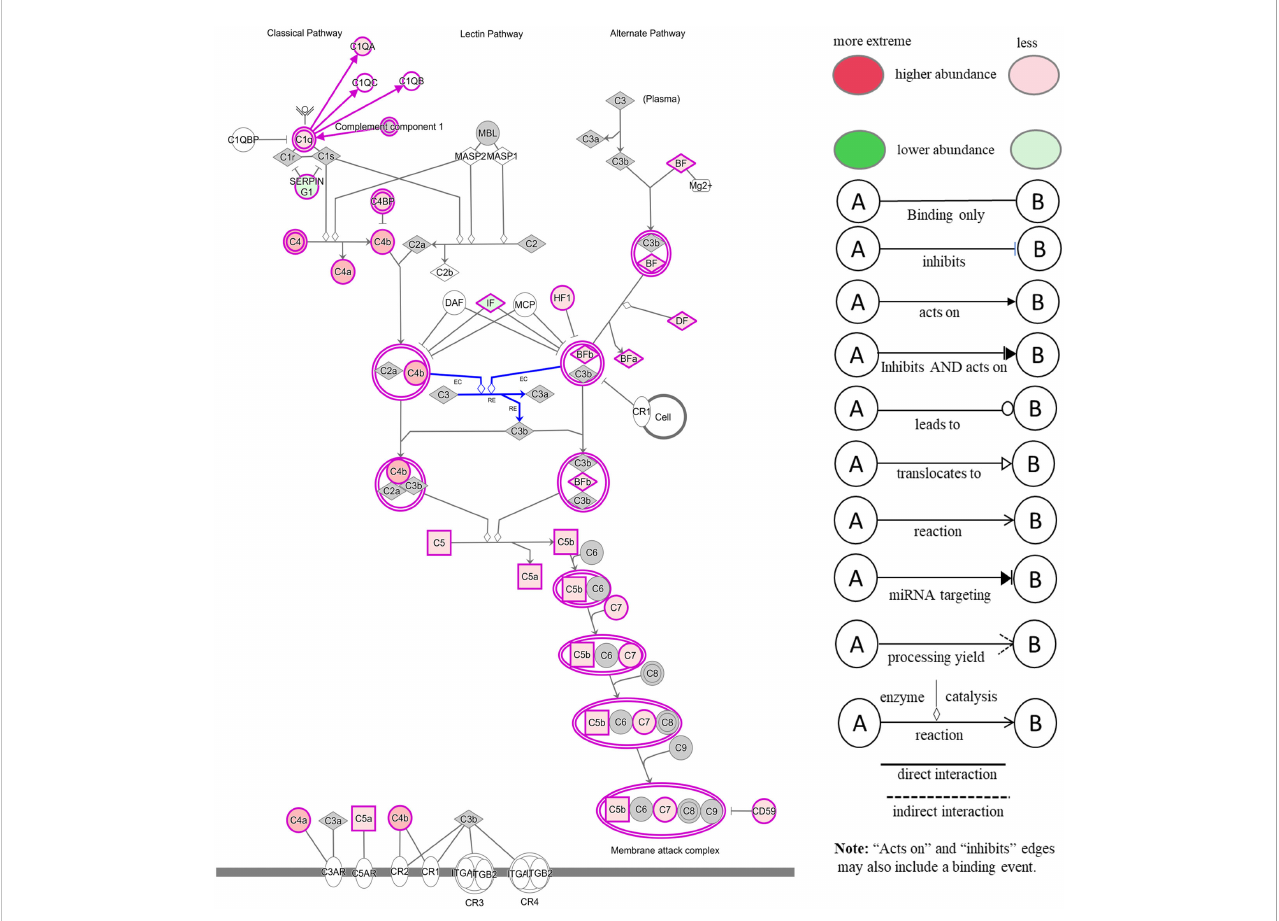
FIGURE 9 Ingenuity pathway analysis for the signi fi cantly differentially abundant proteins in tick-resistant naïve cattle, when compared to susceptible naïve cattle. The DAPs contributed to the complement activation through both classical and alternative pathways. Red boxes indicate proteins with higher abundance and green boxes represent proteins at lower abundance in tick-resistant naïve cattle. White nodes indicate molecules from the knowledge base- not part of the dataset, and the Gray fi ll color identi fi es the focus (analysis-Ready) molecules from that